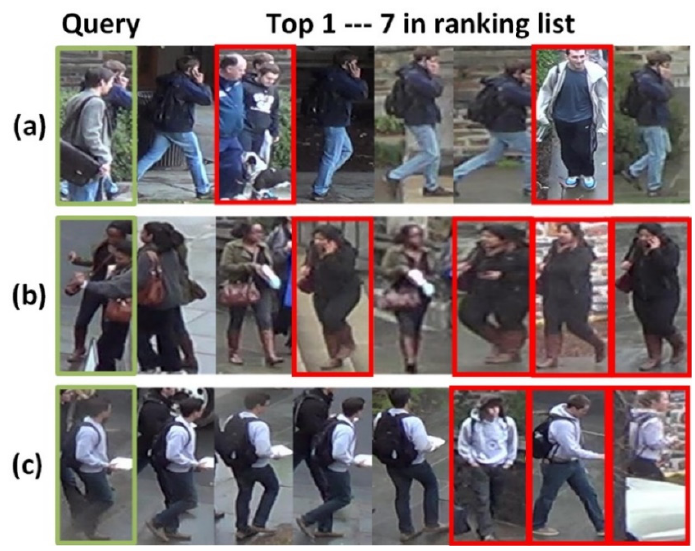
Figure 1. Ranking performance of BagTricks on DukeMTMC-ReID. The green box represents the correct target pedestrian image retrieval, and the red box represents the wrong retrieval results. ( a ) Sample 1; ( b ) Sample 2; ( c ) Sample 3.